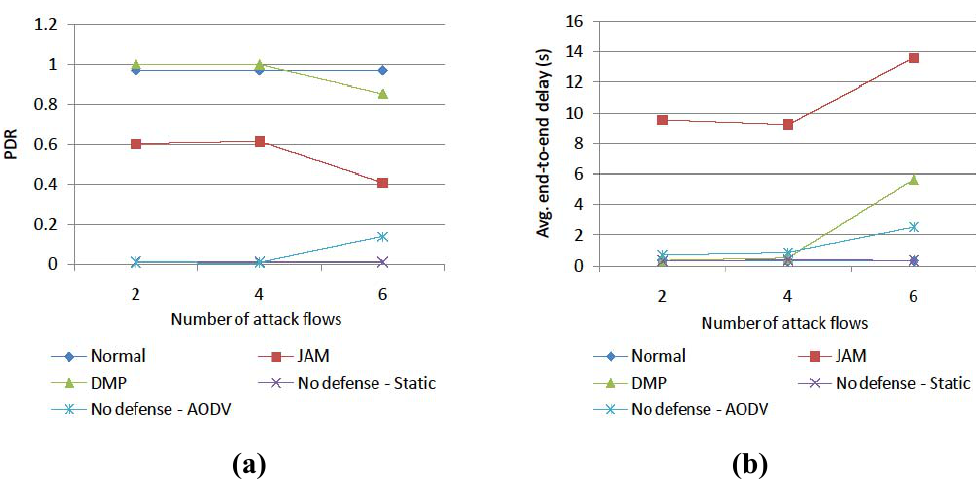
Figure 6. Performance comparison of (a) PDR and (b) delay according to number of attack